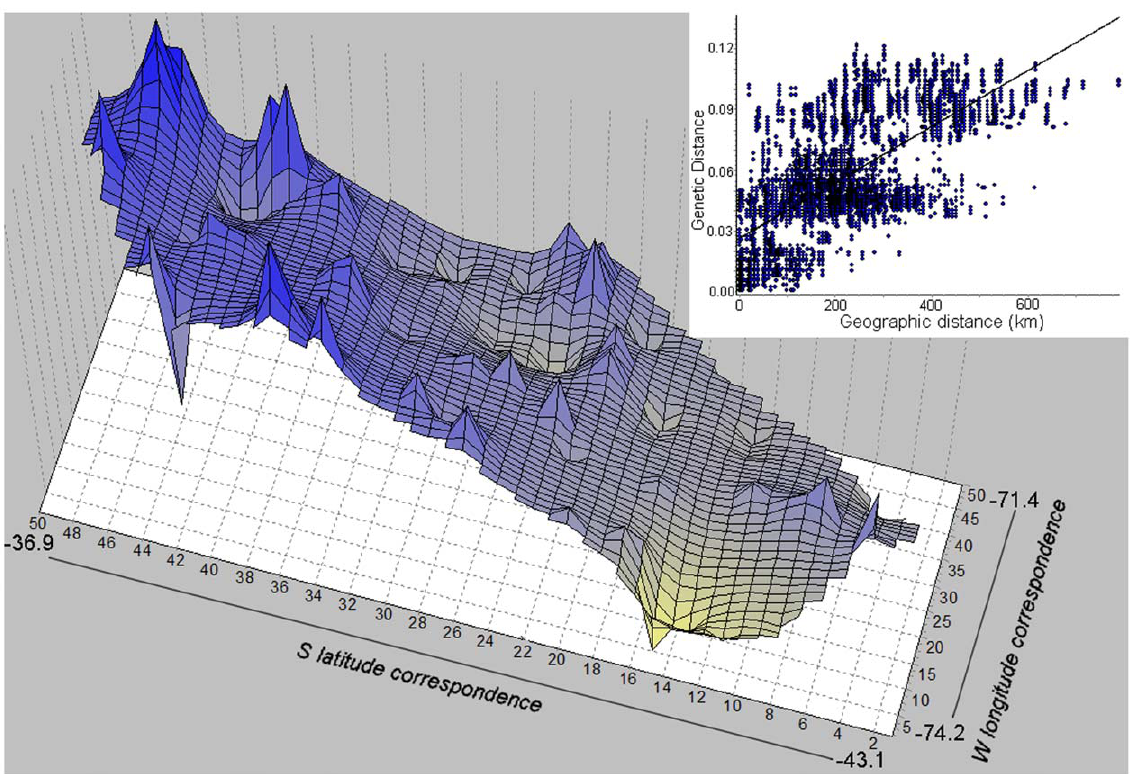
Figure 5. Genetic landscape shape (GLS) interpolation analysis and Isolation by Distance analysis, for L.pictus . GLS was made by using a 50 6 50 grid and a raw genetic distance. X and Y axes correspond to geographic locations within the overall physical landscape examined in this study (Fig. 1). Surface plot heights reflect genetic distances.